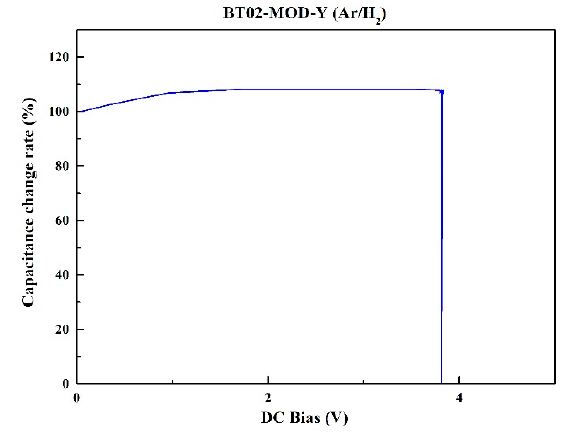
Figure 10. Capacitance change with DC bias for BT02-MOD-Y.